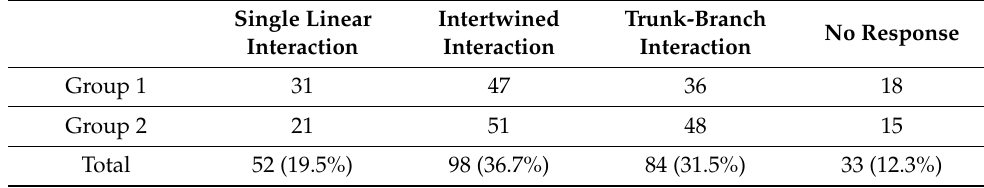
Table 4. Occurrence of